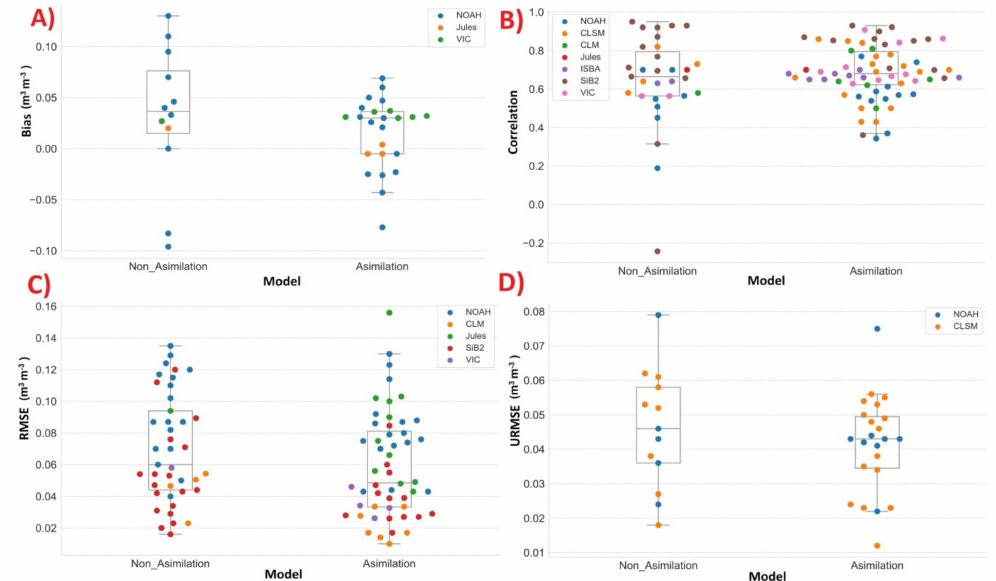
Figure 9. Assimilation results for SSM: ( A ) bias (m3 m-3), ( B ) correlation, ( C ) RMSE (m3 m-3), and ( D ) uRMSE (m3 m-3); the metrics are computed based on estimated SM in LSMs and ground